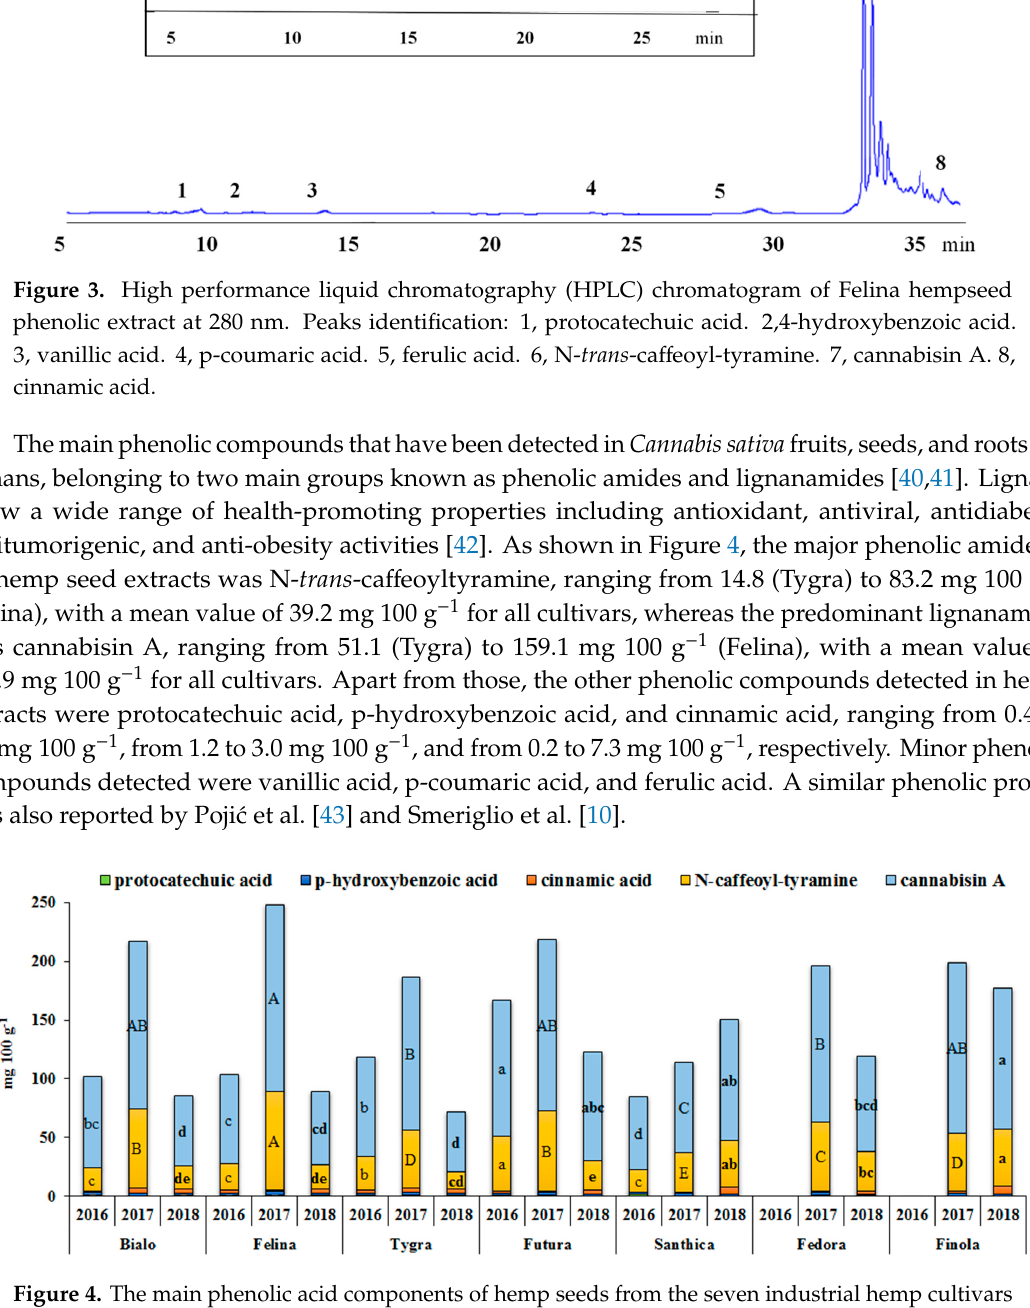
Figure 4. The main phenolic acid components of hemp seeds from the seven industrial hemp cultivars cultivated in this study for three growing seasons (2016, 2017, and 2018). For each year, means within the column in the same color followed by the same letter (lower case, capitals, and lower case in bold for 2016, 2017, and 2018, respectively) are not significantly different ( p > 0.05) (N- trans -caffeoyl-tyramine and cannabisin A are expressed in trans -cinnamic acid equivalents).